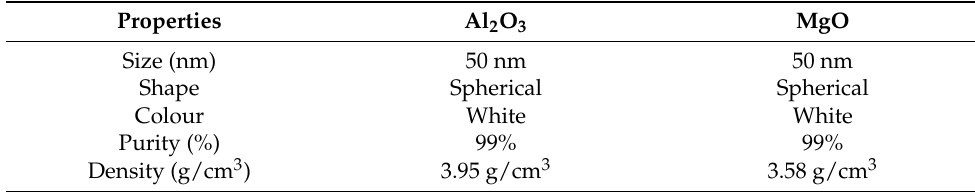
Table 1. Specifications of Al 2 O 3 and MgO nanofillers.